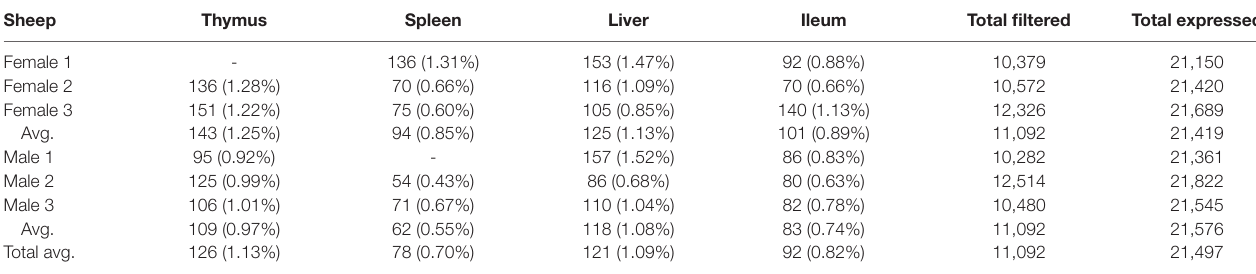
TABLE 1 | Total number of genes with significant static ASE in proportion to genes containing informative SNVs (filtered). Total expressed: Average number of genes being expressed in all 4 tissues. Total filtered: Average number of genes (containing heterozygote loci) passing read bi-allelic filtration criteria in 4 tissues. Tissue break- down has been presented as count